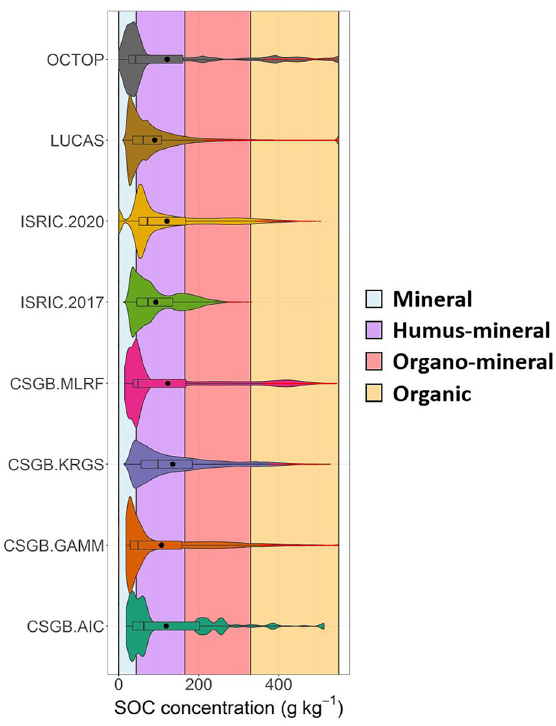
Figure 2. Distributions of modelled topsoil SOC concentrations for each map plotted as combined boxplots and violin plots (outliers in red), with coloured shading of the plot background denoting mineral (0–44 g kg −1 ), humus-mineral (44–165 g kg −1 ), organo-mineral (165–330 g kg −1 ) and organic (330–550 g kg −1 )